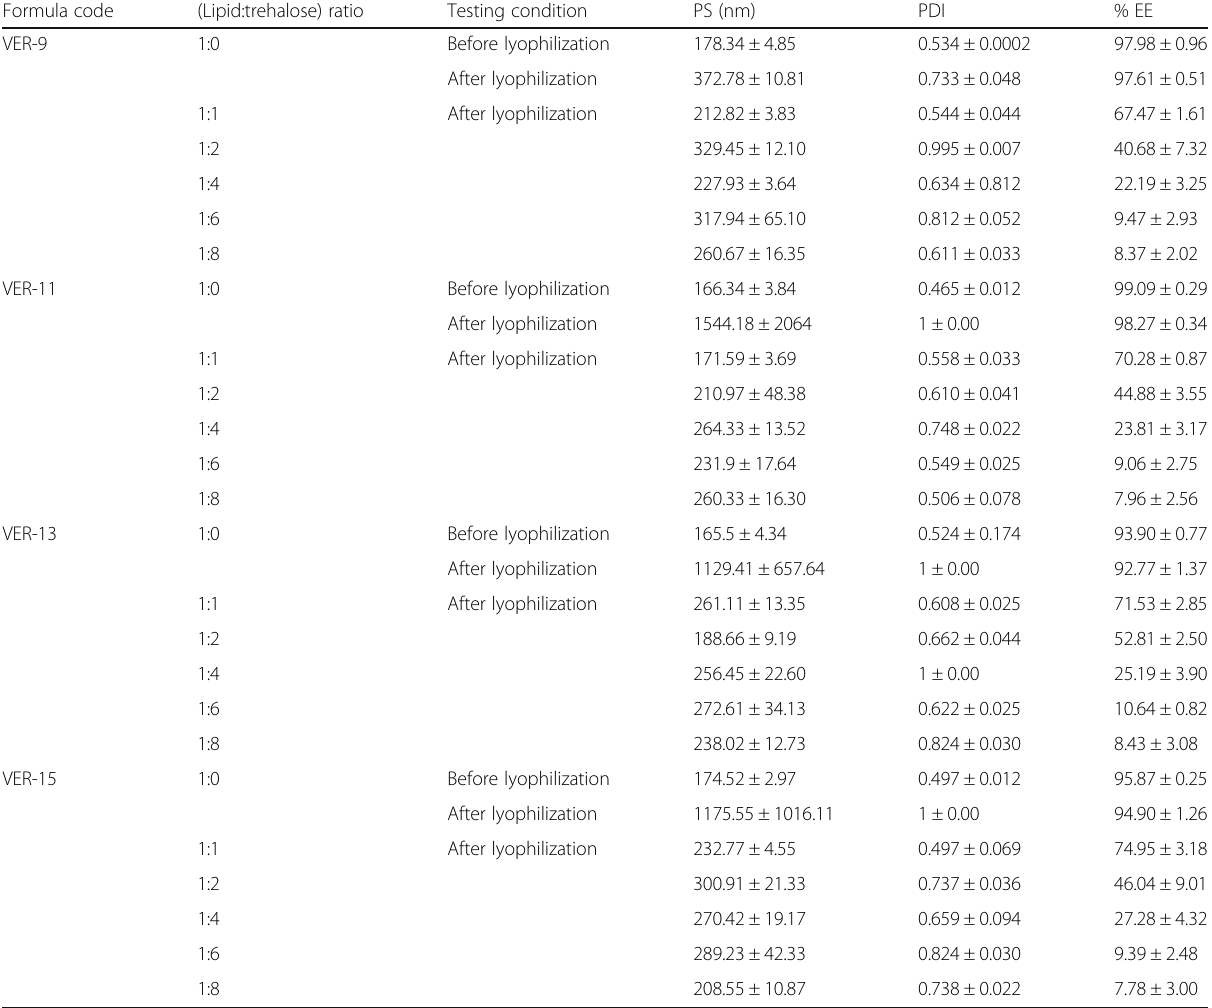
Table 4 Addition of trehalose after homogenization Formula